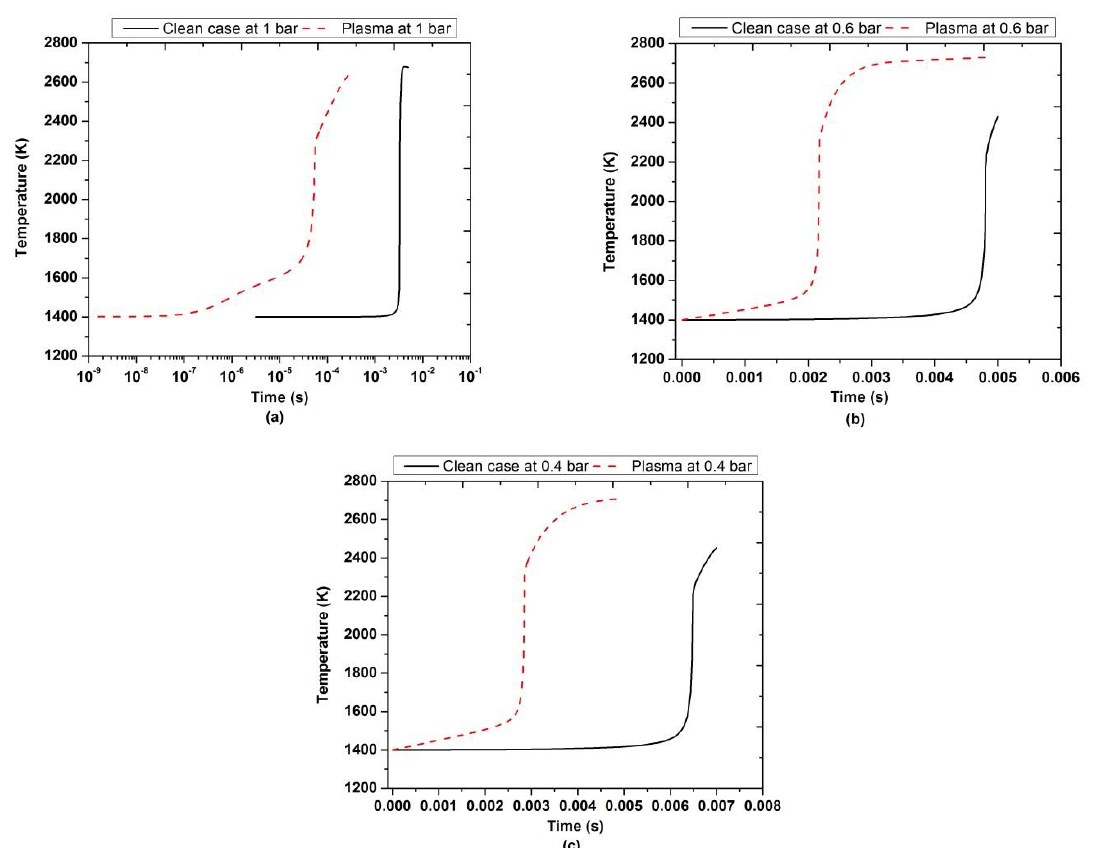
Figure 12. Comparative behavior of ignition characteristics of clean case (without plasma effect, black line) with plasma actuation (red dashed line) at low pressure conditions ( a ) 1 bar, ( b ) 0.6 bar, ( c ) 0.4 bar considering constant inlet temperature 1400 K, E N 200 Td, and stoichiometric conditions.